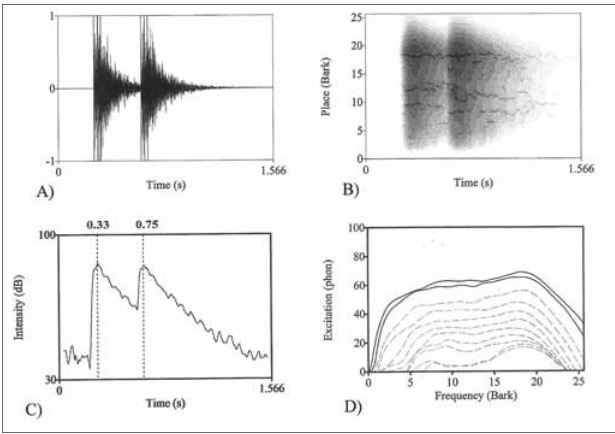
Figure 1. Praat pictures from the .38 revolver second sample (Table 1); A - temporal graph (oscillograph); B - Bark temporal position cochle- ograph; C - sound intensity level temporal graph (dB) with maximum values in 0.33s and 0.75s; D - spectral excitation graph ( fon scale ) where more external continuous lines correspond to a greater degree of excitation for time instants: 0.36s and 0.67s for the two shooting sequences of the sample.